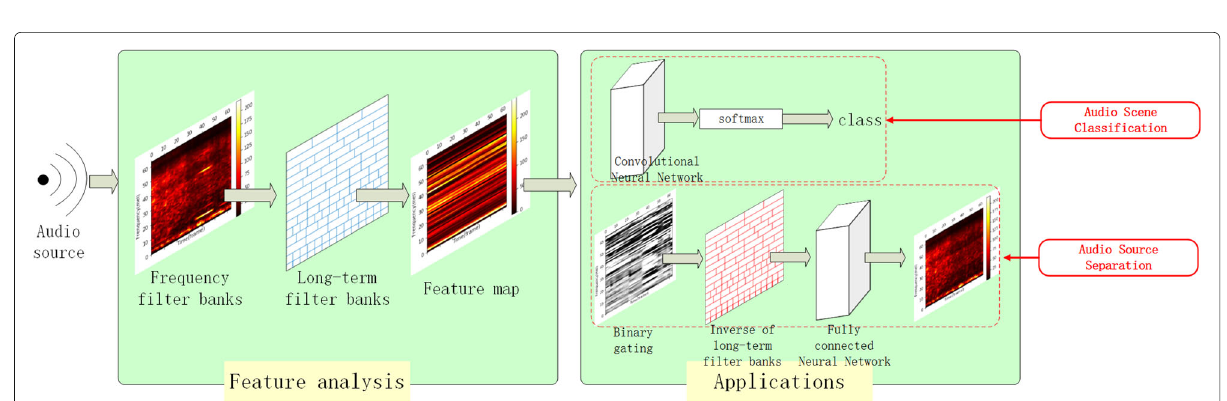
Fig. 2 Long-term filter banks learning framework. The left part of the framework is the feature analysis procedure including STFT, frequency filter banks and long-term filter banks. The right part is the application examples of the extracted feature map, such as audio scene classification and audio source separation. Long-term filter banks in the feature analysis procedure and the back-end application modules are stacked into a deep neural